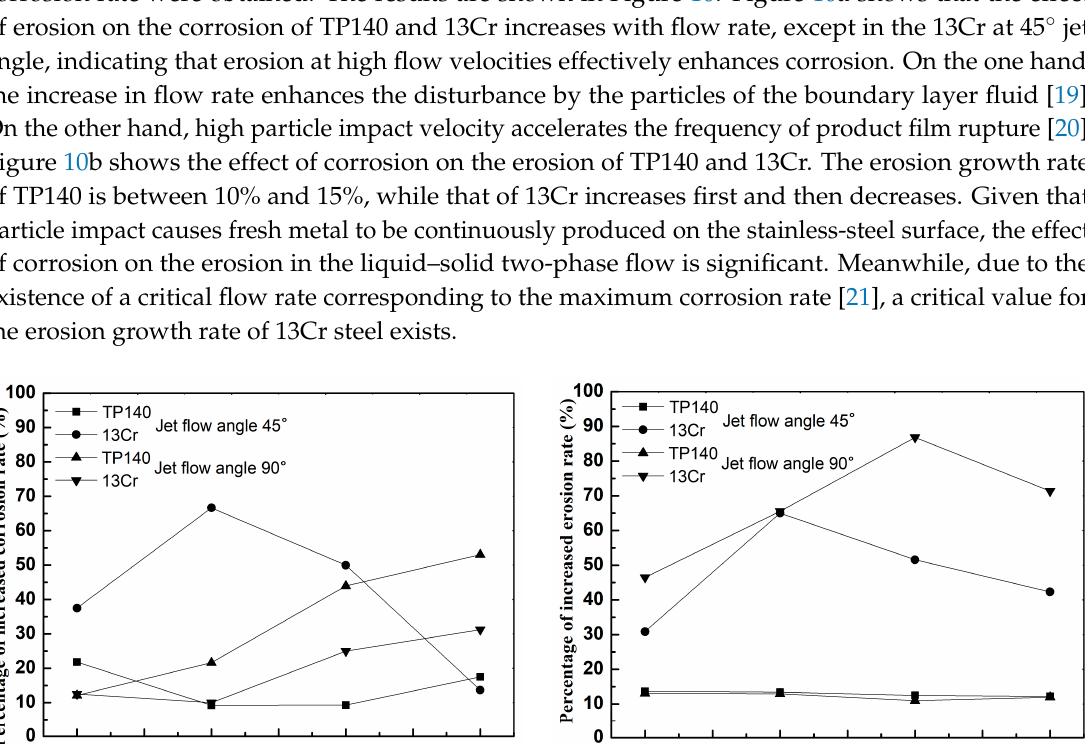
Figure 9. Map of dominant factors for TP140 and 13Cr.